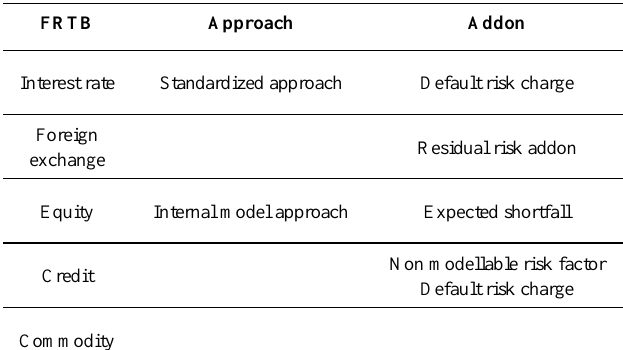
Table 2. Standardized and internal model